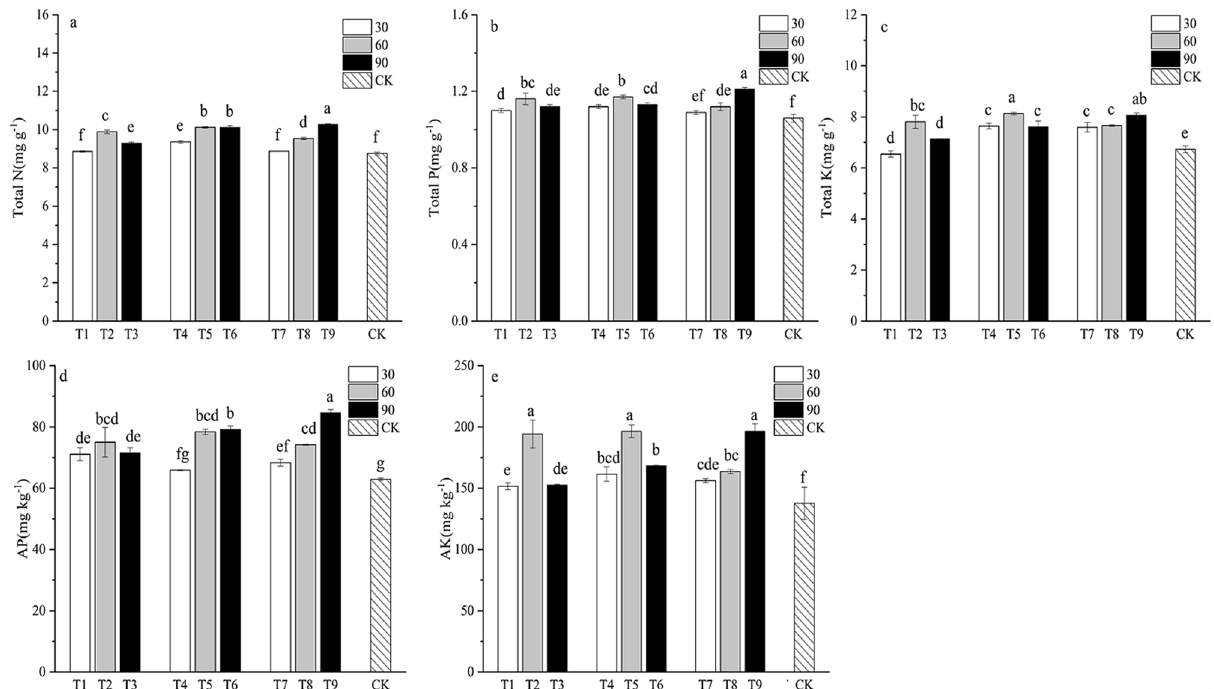
Figure 4. Soil nutrient content of Chinese fir at 90 days after inoculation of PSBs. ( a ) Soil total N content. ( b ) Soil total P content. ( c ) Soil total K content. ( d ) Soil AP content. ( e ) Soil AK content. Different lowercase letters represent significant differences at p <